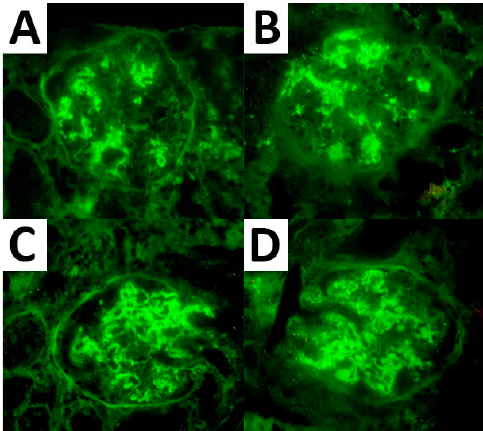
Figure 1. IF expression pattern regarding IgG ( A ), C3 ( B ), and κ ( C ) and λ ( D ) light chain in a case of FGN. All FGN cases presented fibrils deposits on the EM analysis. Fibrils showed a straight and non-branching structure, a random organization, and a mean diameter of 20.92 nm (± 3.53) (Figure 2). Figure 2. Ultrastructural features of FGN. Fibrils deposits were located in the glomerular basement membrane ( A ) 5200× original magnification; ( B ) 8900× original magnification, showing a straight non-branching structure and a random organization ( C ); 28,500× original magnification. Details of the LM, IF, and EM features are reported in Table 4. Table 4. Histopathology, immunofluorescence, and ultrastructural characteristics of the FGN co- hort. Light Microscopy